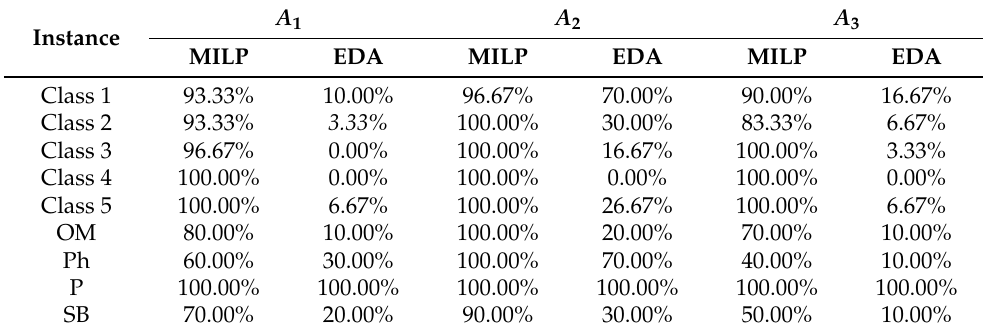
Table 1. The percentages of instances of each class where the results of the proposed methods were better than or equal to the results of MILP and EDA methods.